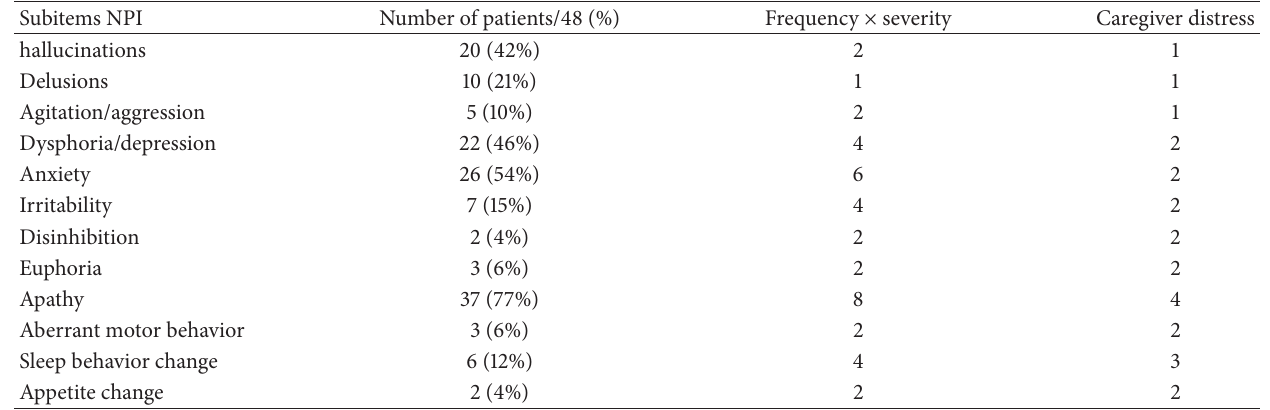
Table 3: Baseline NPI results.